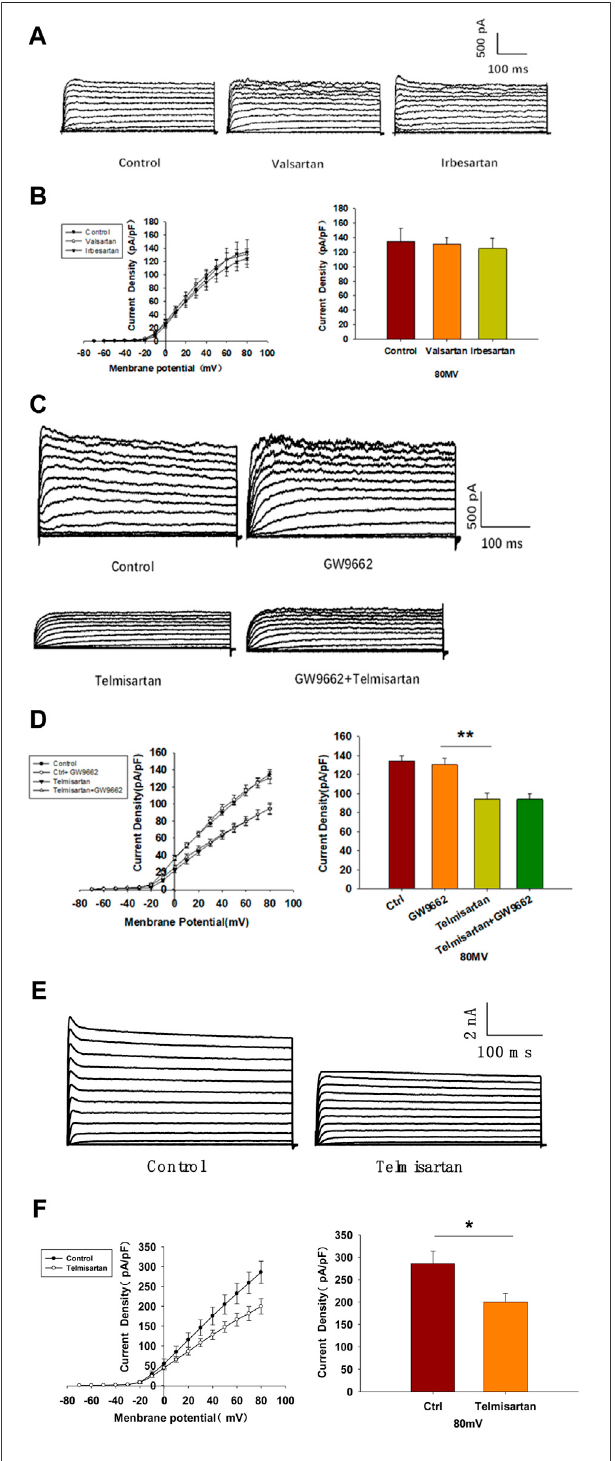
FIGURE 6 | The AT-1 receptor and PPAR γ are not involved in the telmisartan-induced inhibition of Kv channels, whereas telmisartan exerts a direct effect on Kv2.1 channels. (A) Representative current traces recorded upon treatment with valsartan (10 μ M) and irbesartan (10 μ M) in β -cells. (B) Current-voltage relationship curves and the summary of the mean current density of Kv channels recorded at 80 mV depolarization (control n (cid:1) 7 cells,